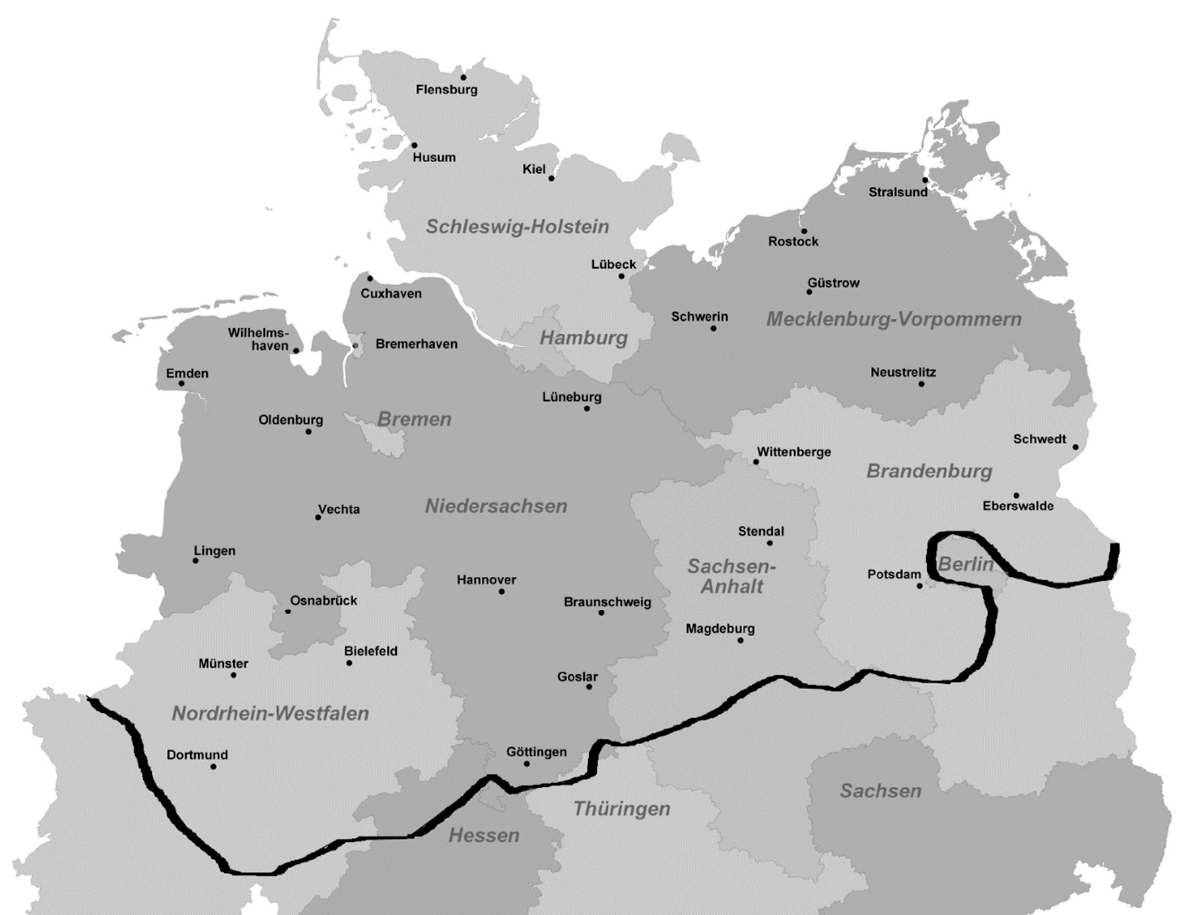
Figure 1. The area of Low German (cf. Goltz and Kleene 2020, p. 172). Standard German started to be used in the Low German language region in the 16th century; from its initially limited use in the written and spoken language used by the upper social classes, it spread more and more until it was finally used as a spoken language by the entire population on a broad basis. This last step took place at different times in different regions, most recently probably in East Frisia and Schleswig-Holstein in the second half of the 20th century (cf. Elmentaler 2009). Today, for most of the region’s inhabitants, Standard German is the language used in all communicative contexts. Low German occurs only to a very limited extent and, above all, only orally, that is in communication situations of close communicative proximity (with the family or in small-scale, locally bound speaker groups, see Höder 2011). It also plays a special role in radio broadcasting, theater, and everyday oral communication in certain occupations such as agriculture and care of the elderly. Stellmacher describes the linguistic situation as being a kind of latent or hidden diglossia (cf. Stellmacher 2000; see also Wiggers 2012) since Standard German is, in principle, used by everyone. The characterization of spoken Low German as a language of proximity ( Nähesprache ) also extends to Low German written language (cf. Elmentaler 2009, p. 36ff.). One characteristic stylistic difference between written Low German and written Standard German is that conventionalized oral-narrative forms are common in written Low German (simulation of the oral form). In addition, there is no supra-regionally standardized and codified orthography in Low German, but rather various spelling systems compete with each other (cf. Kellner 2002, cited in Elmentaler